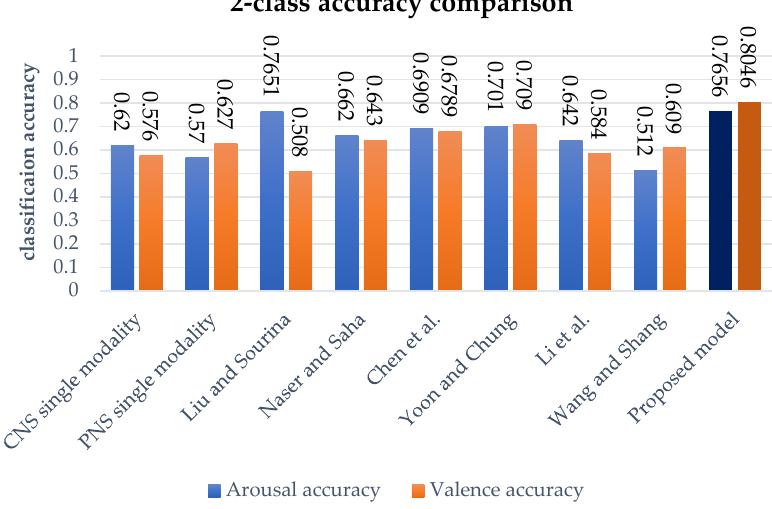
Figure 7. Arousal and valence classification accuracy.